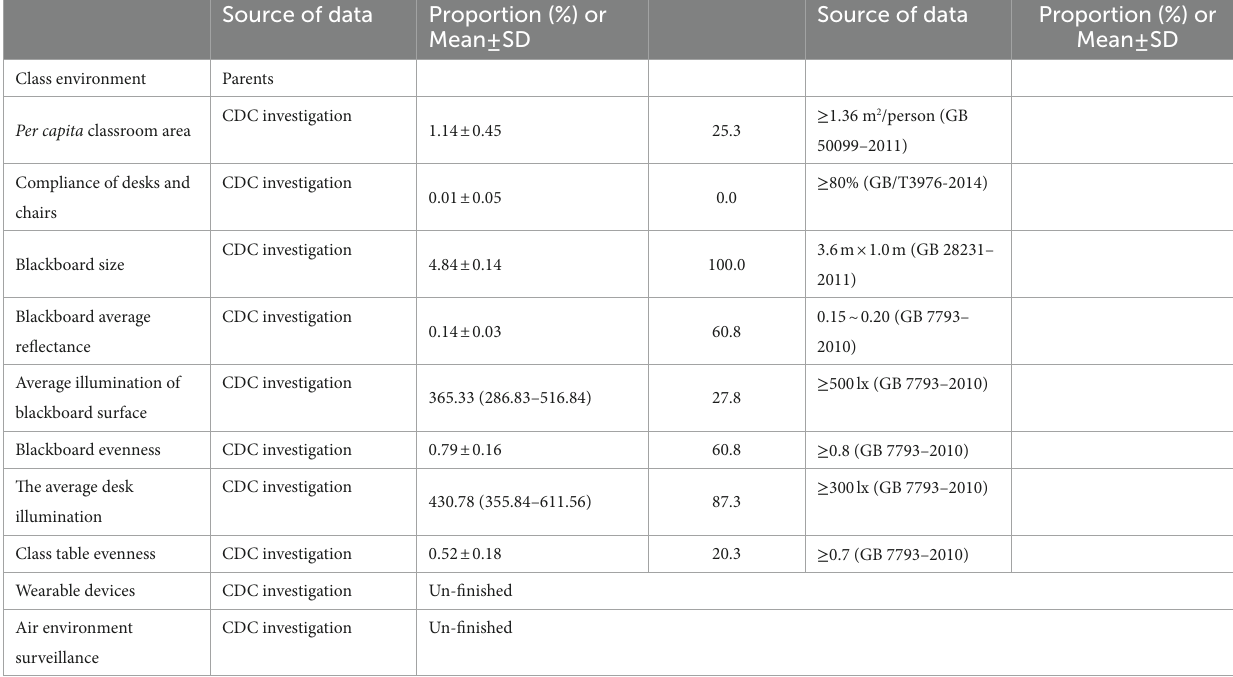
TABLE 5 Environment-related indicators measurements.